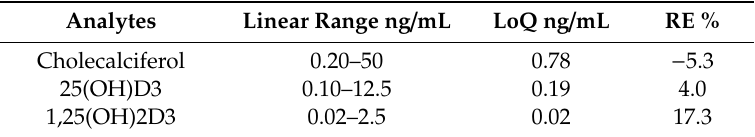
Table 2. Linear range, limits of quantification (LoQ) and RE % for the 3 metabolites derivatized